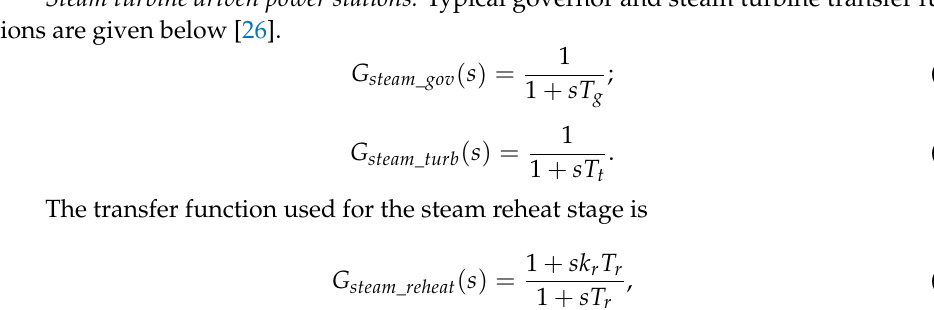
Figure 6. A 3D graph of fuzzy system output. Table 1. Fuzzy rules for power change factor